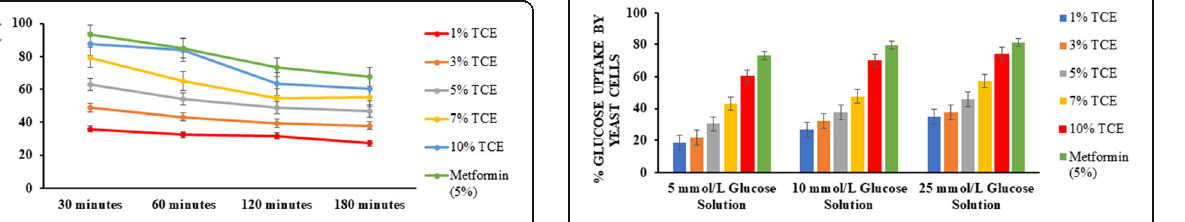
Fig. 1 GDRI of the different concentrations of T. cacao husk extract and Metformin as a function of time